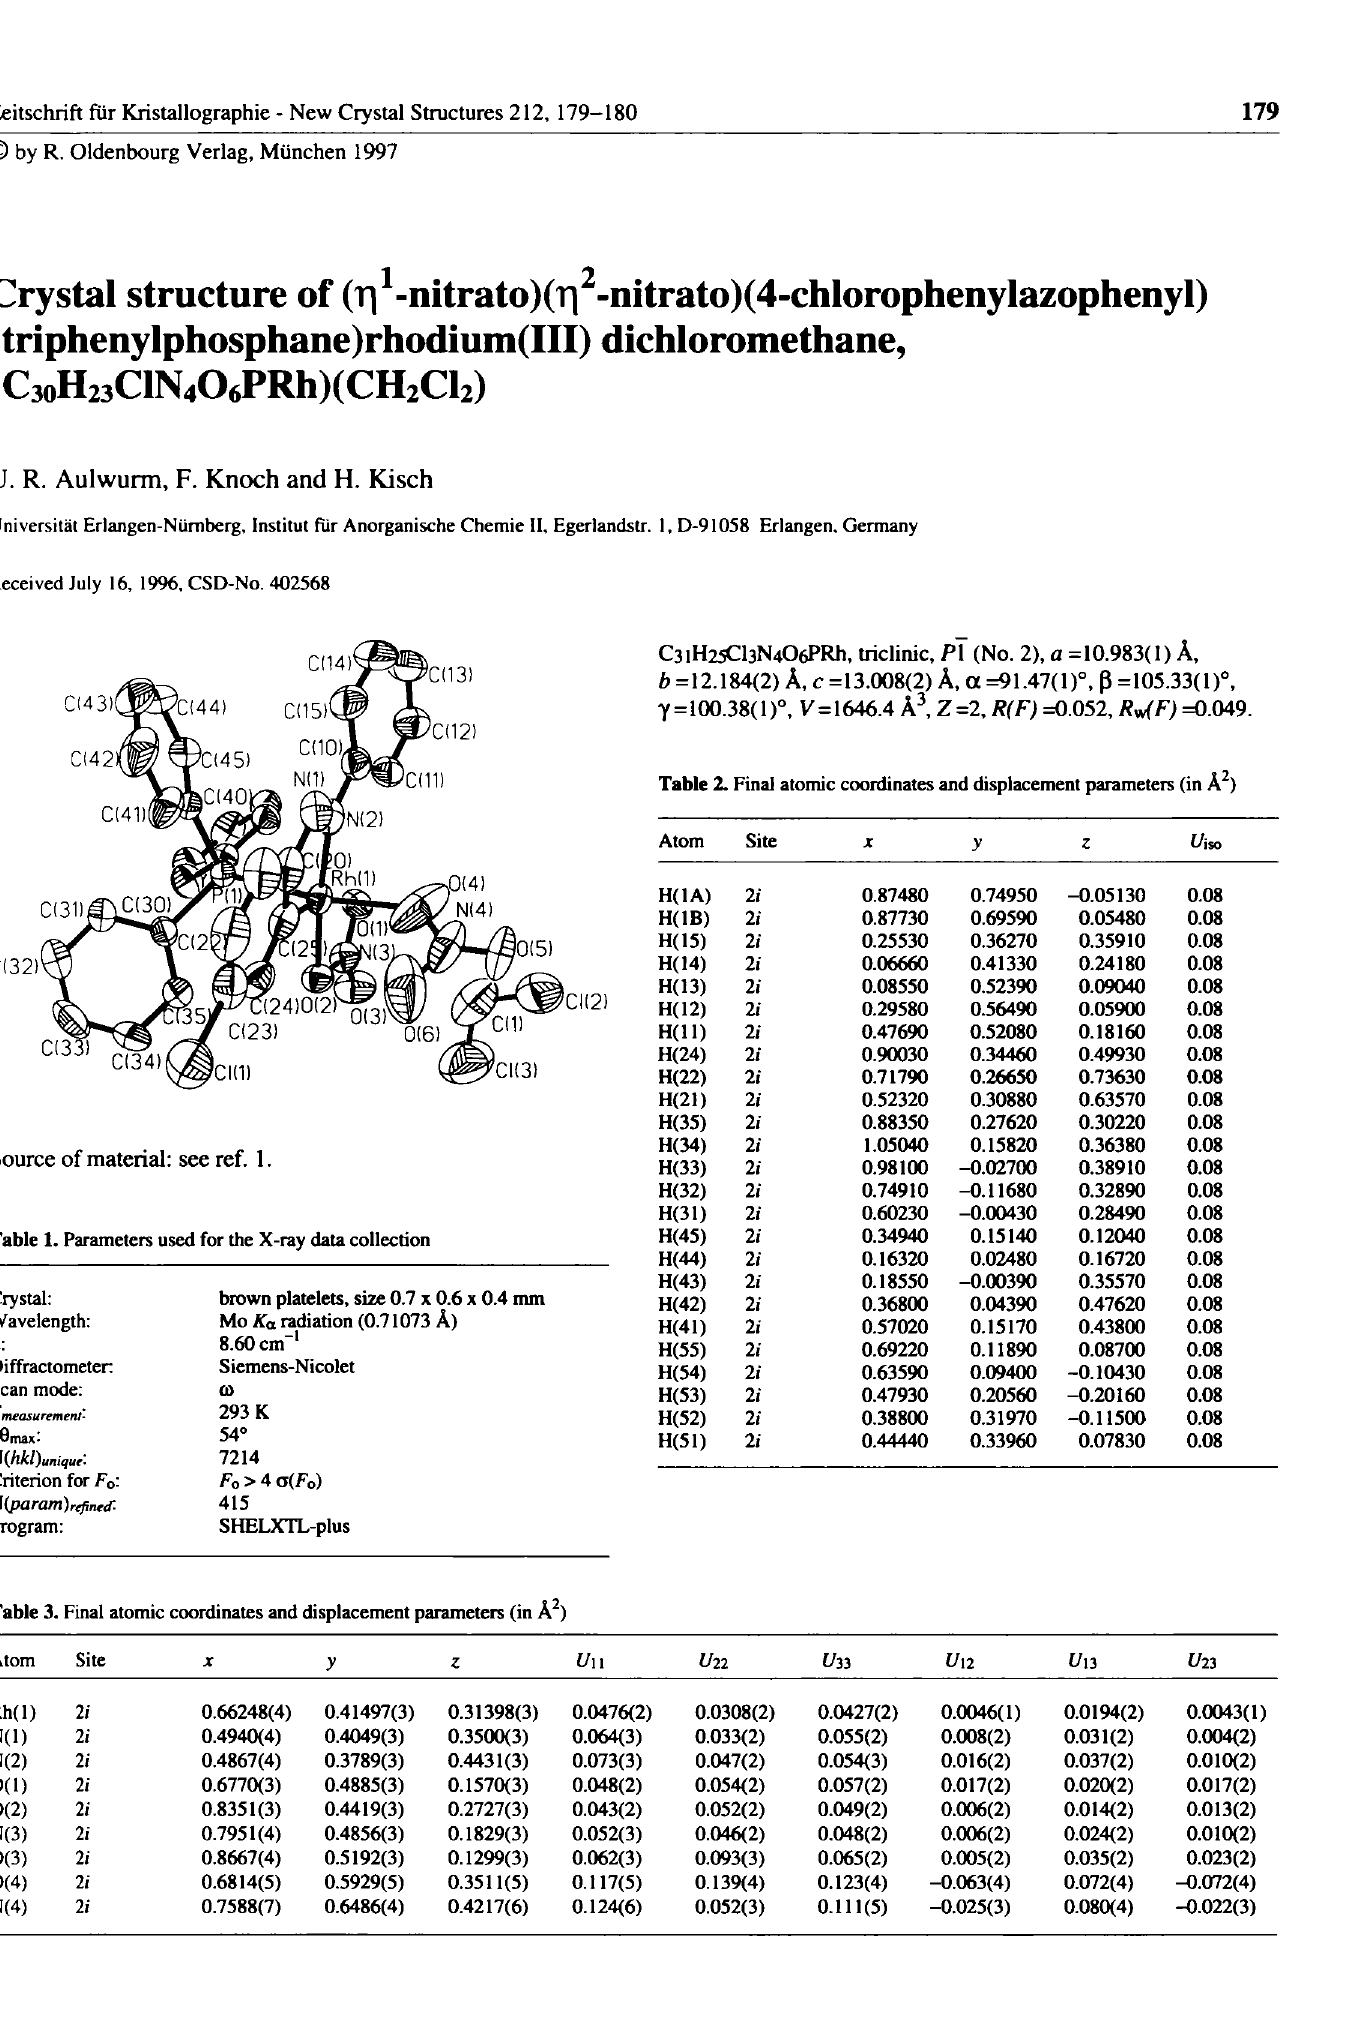
Table 3. Final atomic coordinates and displacement parameters (in Â 2 )